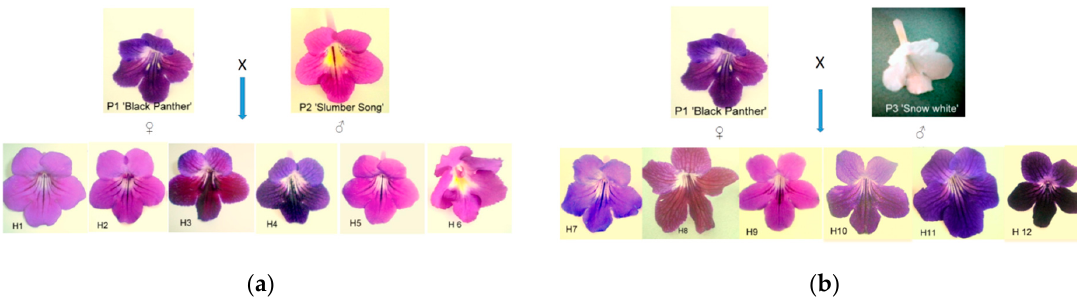
Figure 1. Flower colors of the Streptocarpus progenies due to cross pollination: ( a ) flower color of the F1 progenies (H1–H6) from the parental cross P1 × P2 ( ♀ “Black Panther” × ♂ “Slumber Song”) and ( b ) flower color of F1 progenies (H7–H12) from the parental cross P1 × P3 ( ♀ “Black Panther” × ♂ “Snow White”). Table 1. Colors and Royal Horticultural Society Color Chart (RHSCC) code of genitors and F1 progenies selected for sequence-related amplified polymorphism (SRAP) and Fourier-transform infrared (FT-IR) analyses.